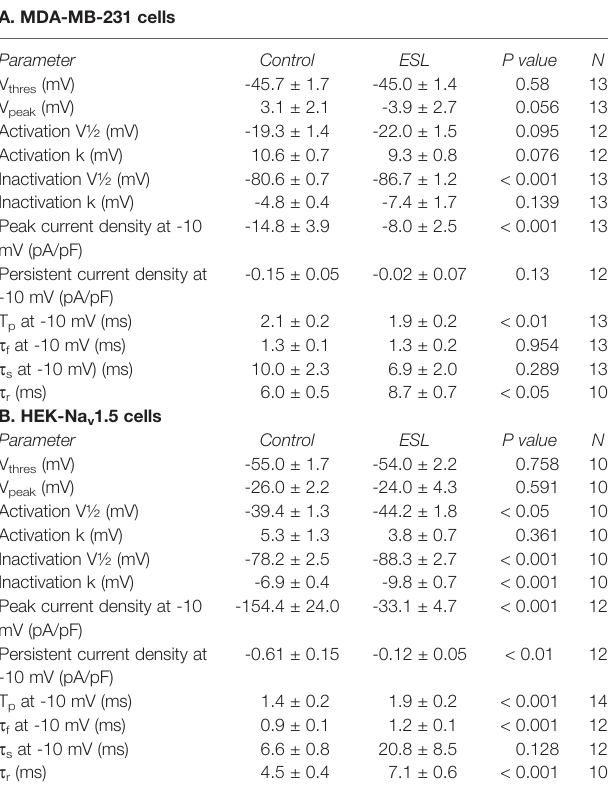
TABLE 2 | Effect of S-licarbazepine (300 m M) on Na + current characteristics in MDA-MB-231 and HEK-Na v 1.5 cells.